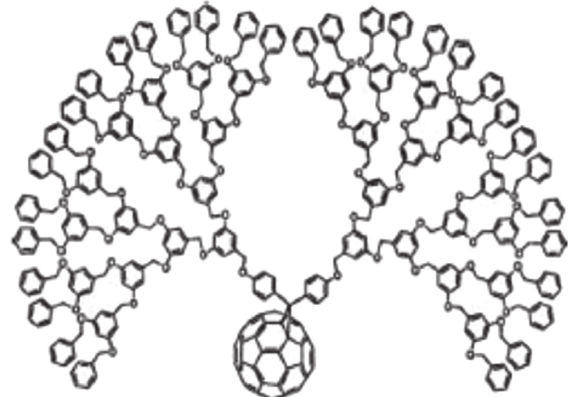
Figure 3: Fullerene dendrimer NS